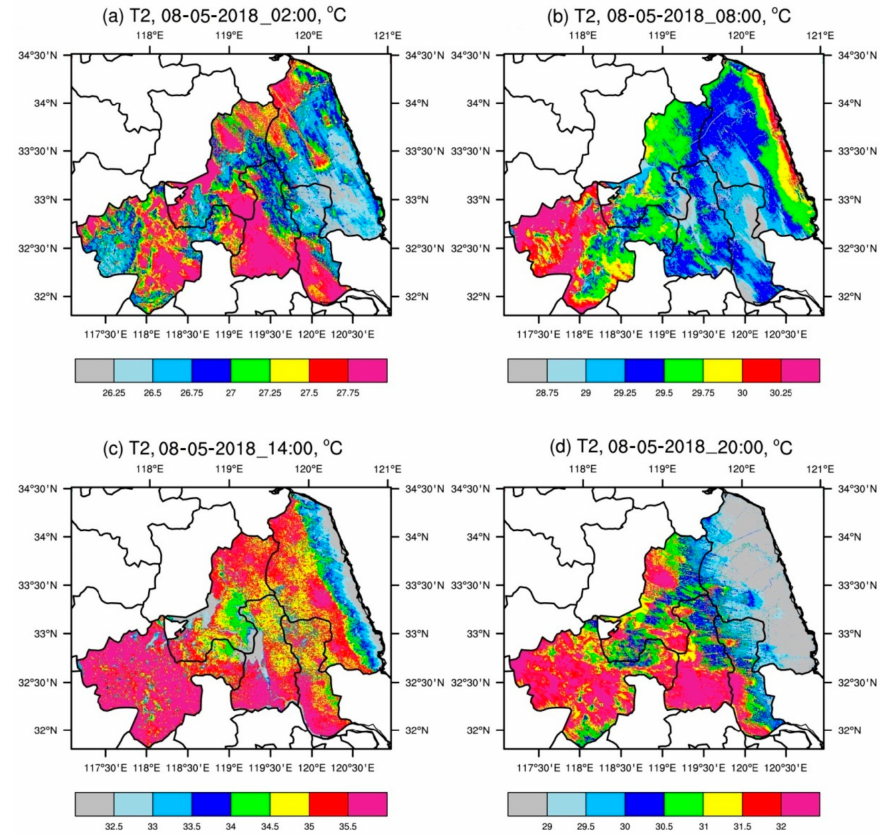
Figure 9. Daily variation of air temperature at 2 m in WRF model on simulated